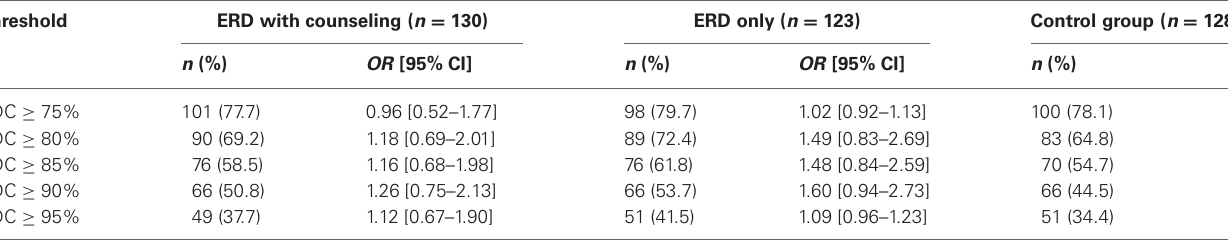
Table 4 | Result of sensitivity analysis: number and percentage of adherent patients when different thresholds were used for the definition of